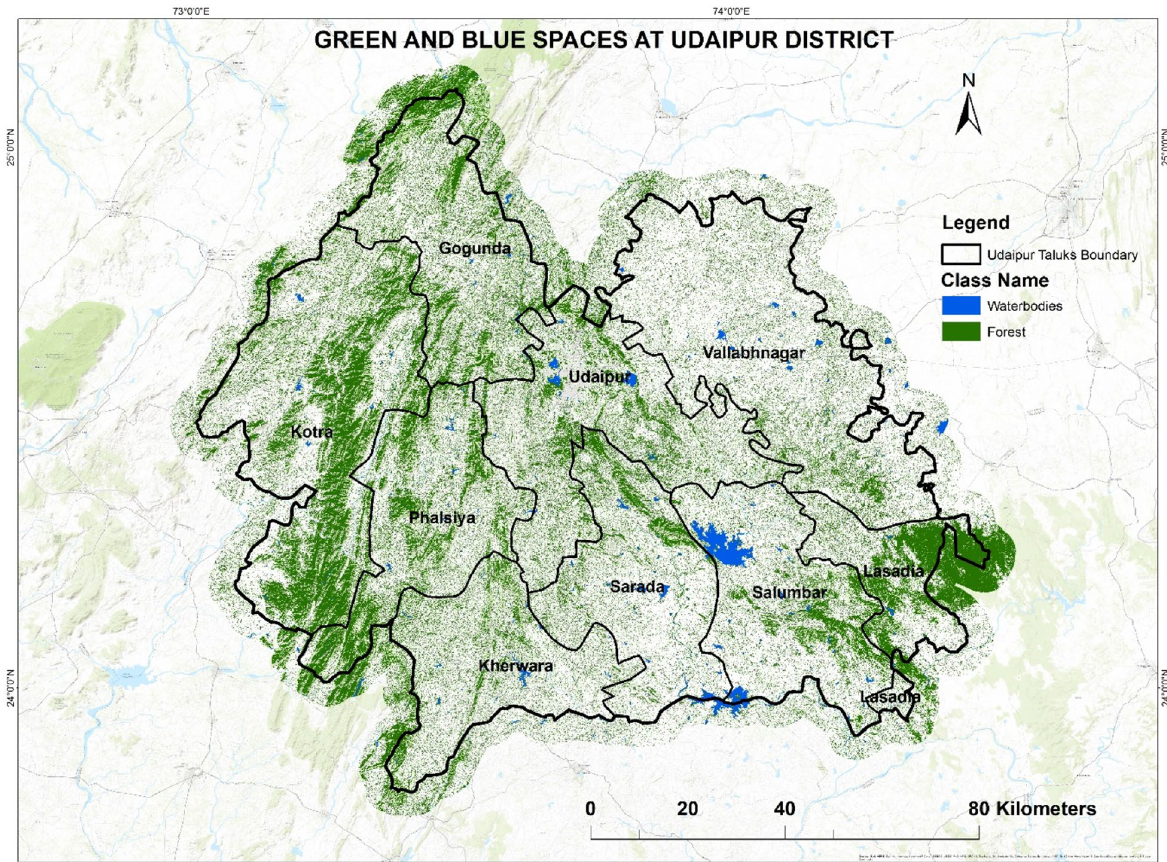
Fig. 10 Distribution of Blue-Green Spaces over different